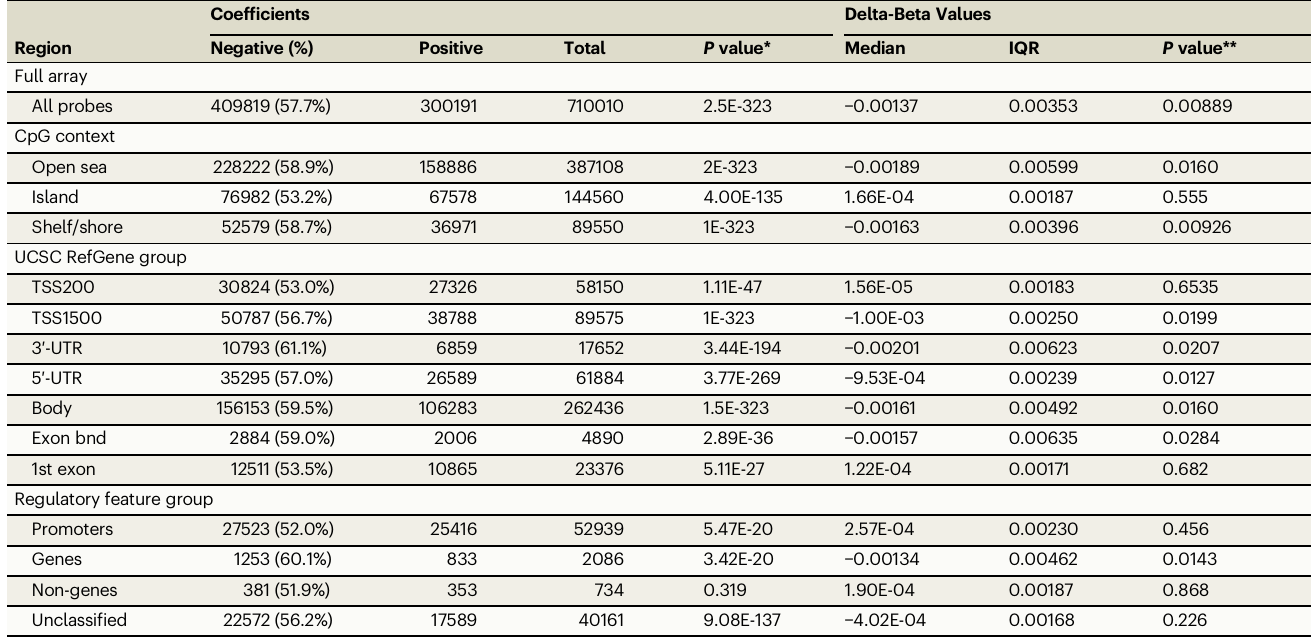
Table 4 | Coef fi cient directional bias based on associated CpG region Coef fi cients Delta-Beta Values